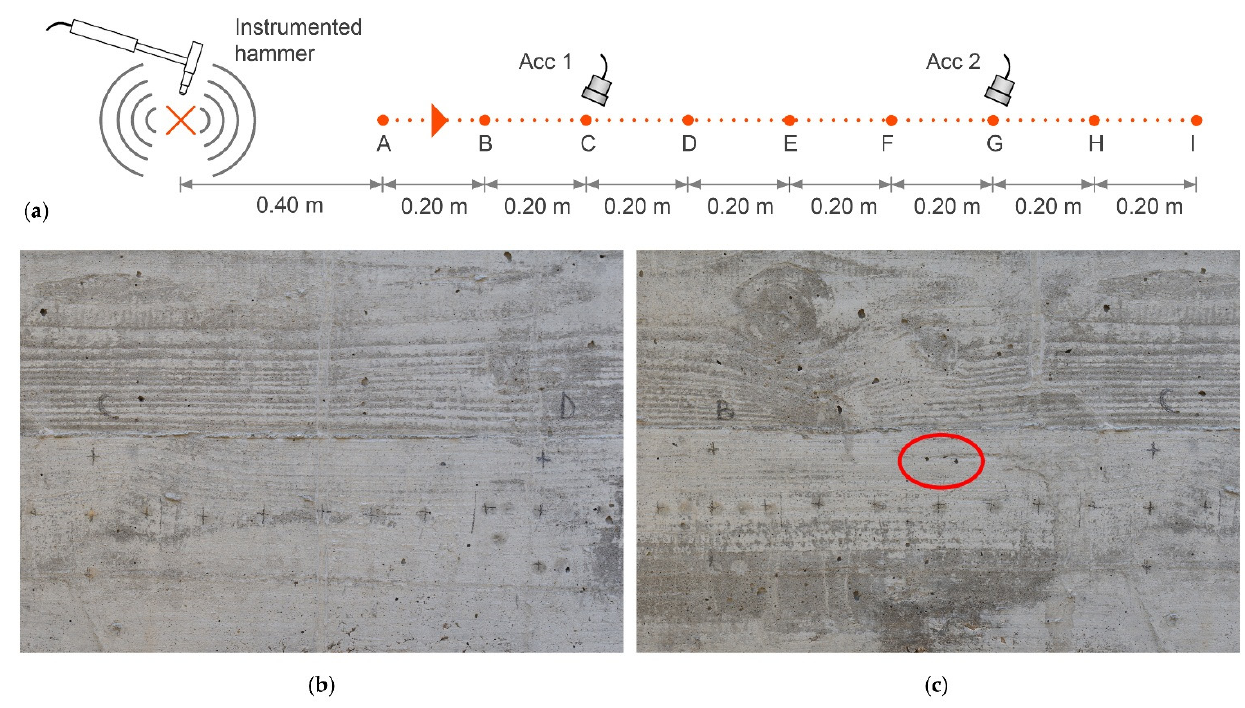
Figure 5. ( a ) The layout of the ten measurement point positions; ( b ) Portion of the tested concrete wall with no imperfec- tions in the way of propagation of the R-wave; ( c ) Portion of the wall with some imperfections precisely in the way of waves propagation.